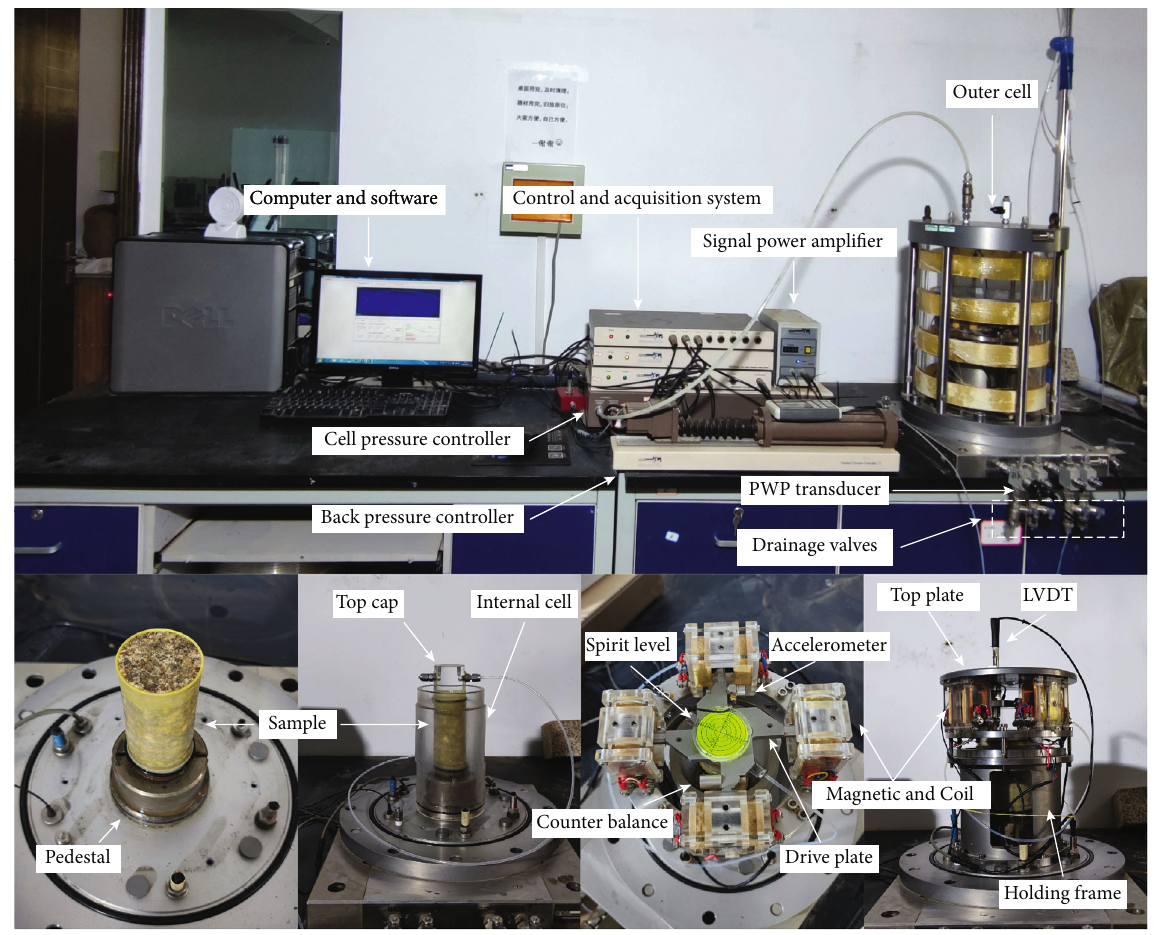
Figure 3: Schematic view of the RCT apparatus. (From Wang et al. [26], Figure